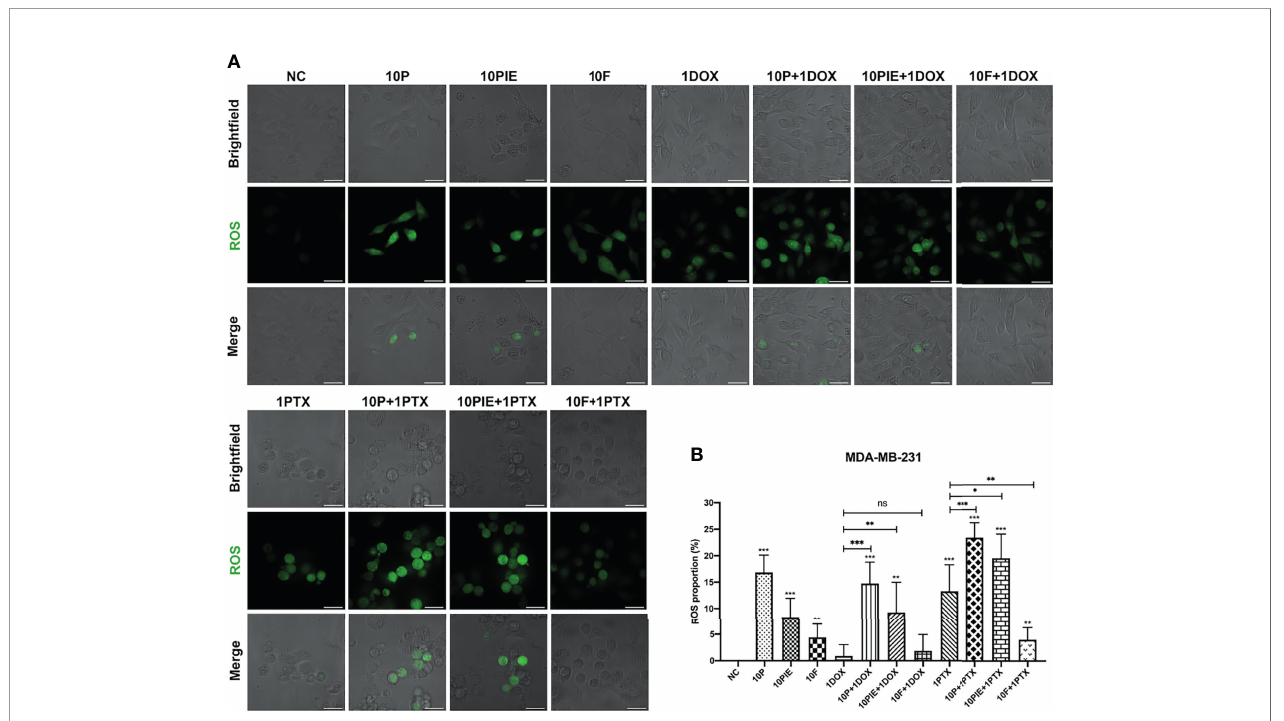
FIGURE 3 | Intracellular ROS level of MDA-MB-231 cells treated with propofol/PIE/fospropofol disodium with or without doxorubicin/paclitaxel. (A) Intracellular ROS level of MDA-MB-231 cells treated with different drugs. ROS positive cells were determined using laser scanning confocal microscopy and indicated as green spots. Bar = 34 µm. (B) Statistical analysis of ROS proportion in MDA-MB-231 cells under different treatments. ns, no signi fi cant difference. * P < 0.05, ** P < 0.01, *** P <